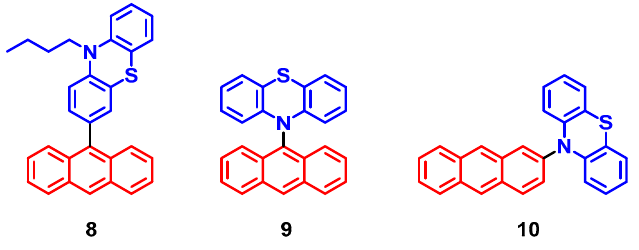
Figure 2. Anthryl-PTZ dyads showing efficient SOCT-ISC.